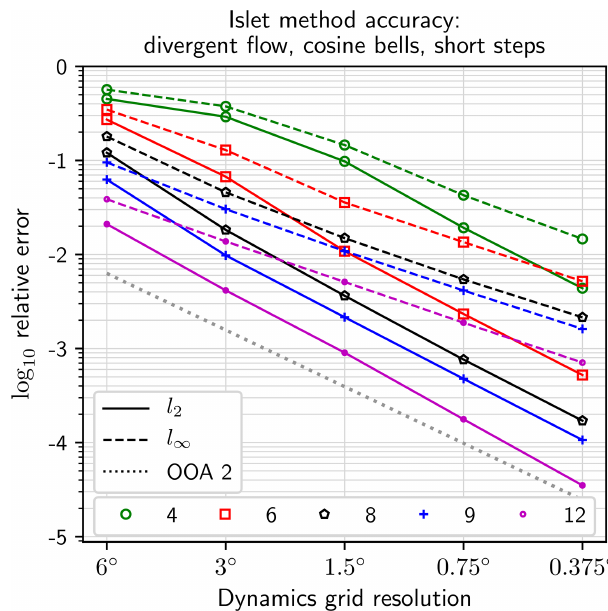
Figure 9. Accuracy diagnostic. Compare with Fig. 16 in